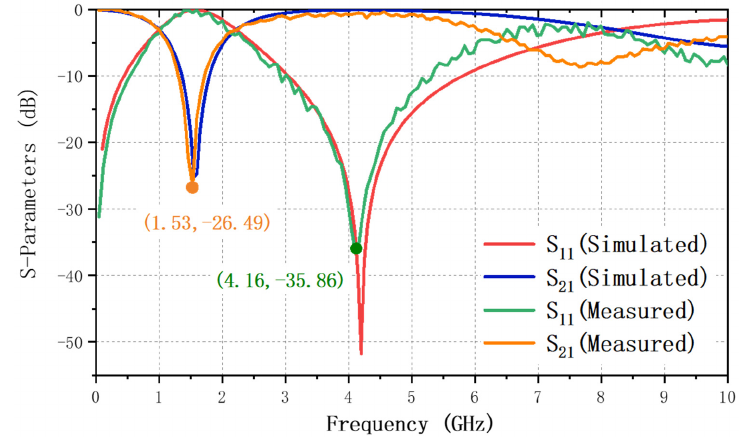
Figure 9. Simulation and measurement results of the S11 and S21 parameters.